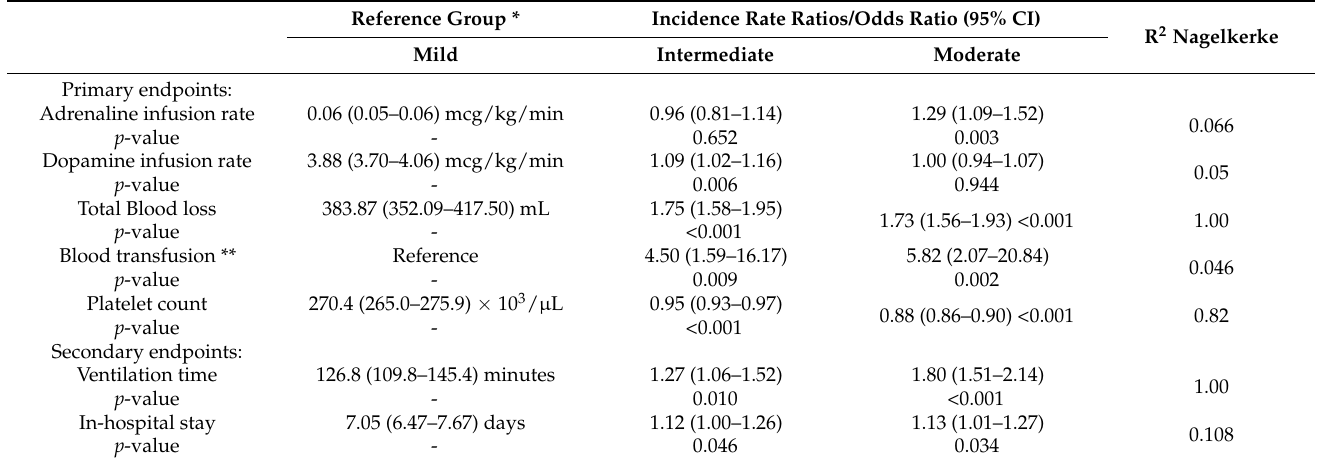
Table 3. Multivariable regression analysis for primary and secondary endpoints.